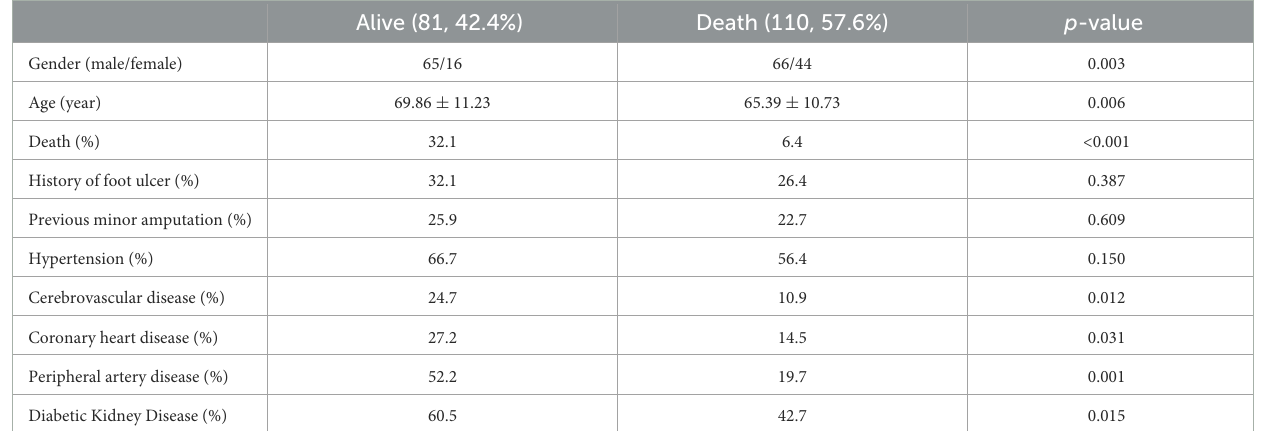
TABLE 4 Chronic disease in DFU patients with and without sarcopenia. Alive (81, 42.4%) Death (110,